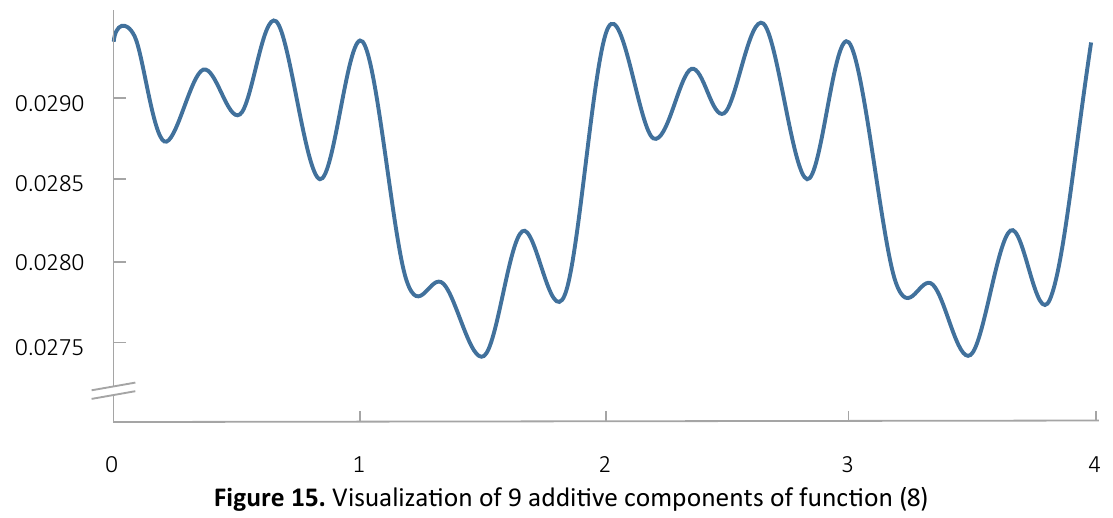
Figure 15. Visualization of 9 additive components of function